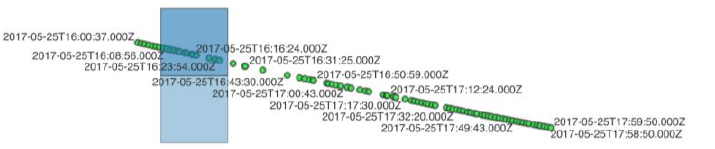
Figure 2. The output of SRP for ship 26, when using KNN.